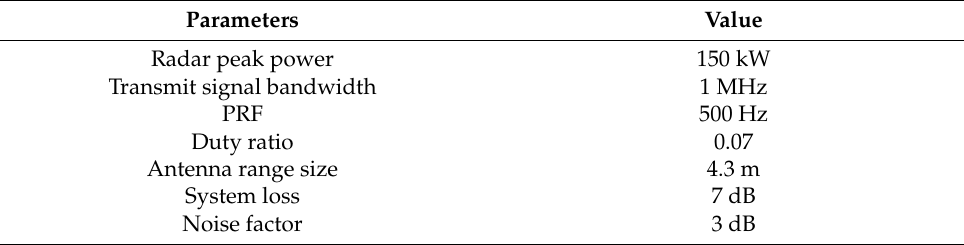
Table 2. Radar system Table 1. Radar network parameters.